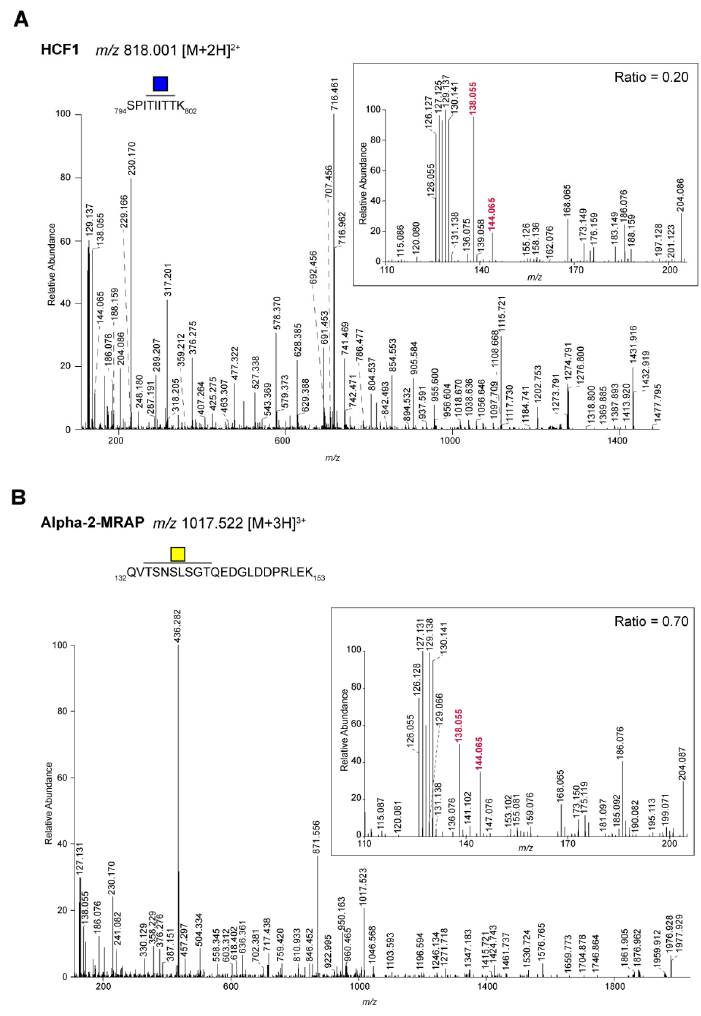
Figure 2. MS/MS spectra of TMT-labeled tryptic O -glycopeptides from CRC cell lines. HCD MS/MS spectra of an O -GlcNacylated ( A ), Host cell factor 1 (HCF1)) and O -GalNacylated ( B ), alpha-2- macroglobulin receptor-associated protein (Alpha-2-MRAP)) TMT-labeled tryptic peptide. Blue square: GlcNAc; yellow square: GalNAc. The inserts show the TMT-reporter (9-plex), oxonium ions and ratio of m / z 144.066/138.055. The oxonium ions at m / z 138.055 and 144.066 used for the ratio are shown in red. Samples were labeled as follows: HT29: 126, 127N,127C; HCT116: 128N, 128 C, 129N; LS174T: 129C, 130N, 130C. Of note, m / z 126.055 represents the oxonium ion [HexNAc-C 2 H 6 O 3 ] +